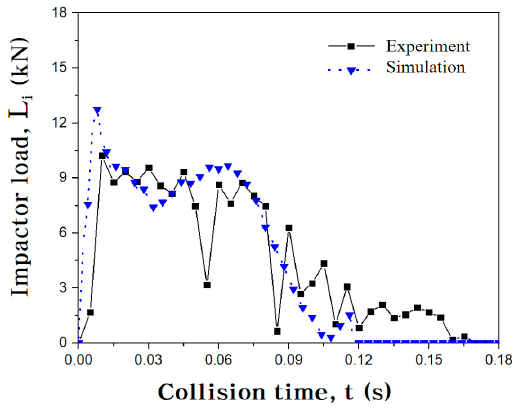
Figure 10. Comparison of the impactor load of the HPF center pillar with PW between the experiment and the simulation